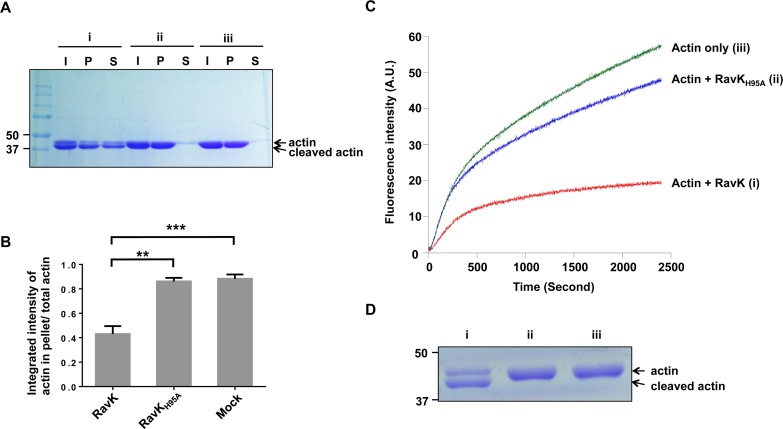
Cleavage by RavK inhibits actin polymerization.A. Cleavage by RavK inhibited actin polymerization in actin sedimentation assay. 30-μg non-muscle actin (Cytoskeleton, 99% purity) was incubated with 5-μg wild-type RavKΔC50 or the catalytically dead mutant RavKH95AΔC50 at 23°C for 2 h. The mixtures were precleared by centrifugation at 100,000g for 30 min and further used in actin sedimentation assays. Actin polymerization was allowed to proceed for 60 min, followed by ultracentrifugation at 100,000g for 40 min. The resulting supernatants and pellets were analyzed by SDS-PAGE followed by Coomassie brilliant blue staining. Groups: i, actin treated with RavKΔC50; ii, actin treated with RavKH95AΔC50; iii, actin without treatment. Lanes: I, input; P, pellet; S, supernatant. B. Quantification of the percentage of polymerized actin versus total actin. The band intensity was quantified with ImageJ. All results are obtained from three independent experiments. Error bars represent standard error of the mean (SEM). **, p<0.01. C. Cleavage by RavK inhibited actin polymerization in a kinetic assembly assay. Non-muscle actin treated by RavKΔC50, RavKH95AΔC50 or a control reaction with RavK was precleared by centrifugation at 100,000g for 30 min. 2.7-μM differently-treated actin and 0.3 μM pyrene-labeled actin were mixed and the fluorescence intensity of pyrene (arbitrary units, a.u.) was plotted versus time after the addition of a polymerization buffer to initiate the polymerization. D. Actin used in pyrene-labeled actin polymerization assay. Actin samples receiving indicated treatment were resolved by SDS-PAGE and detected by Coomassie brilliant blue staining.